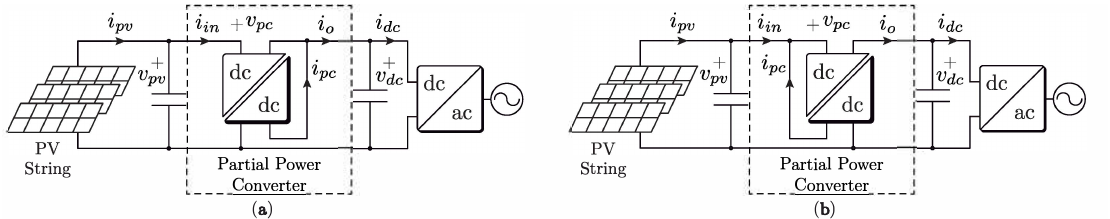
Figure 2. Step-down converter. ( a ) Partial power connection at dc-link side; ( b ) Partial power connection at PV